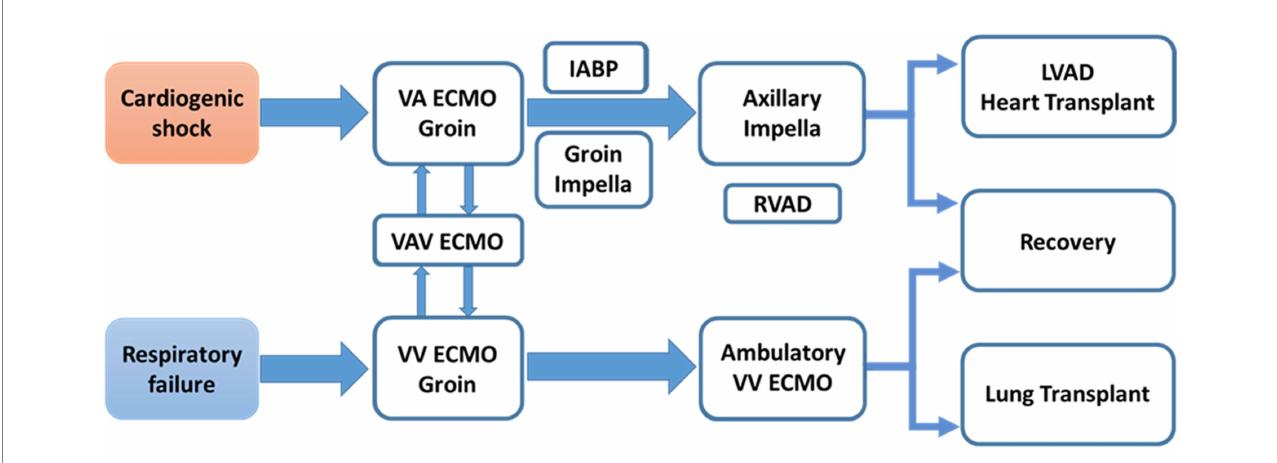
FIGURE 3 MCS de-escalation in patients with CS or heart failure. MCS is not just one time procedure. A team require comprehensive MCS experiences to provide optimal MCS strategy, tailored for patient’s status, and maximal survival benefit. IABP, intra-aortic balloon pump; LVAD, left ventricular assist device; MCS, mechanical circulatory support; RVAD, right ventricular assist device; VA-ECMO, veno-arterial extracorporeal membrane oxygenation; VAV ECMO, veno- arterio-venous extracorporeal membrane oxygenation; VV ECMO, veno-venous extracorporeal membrane